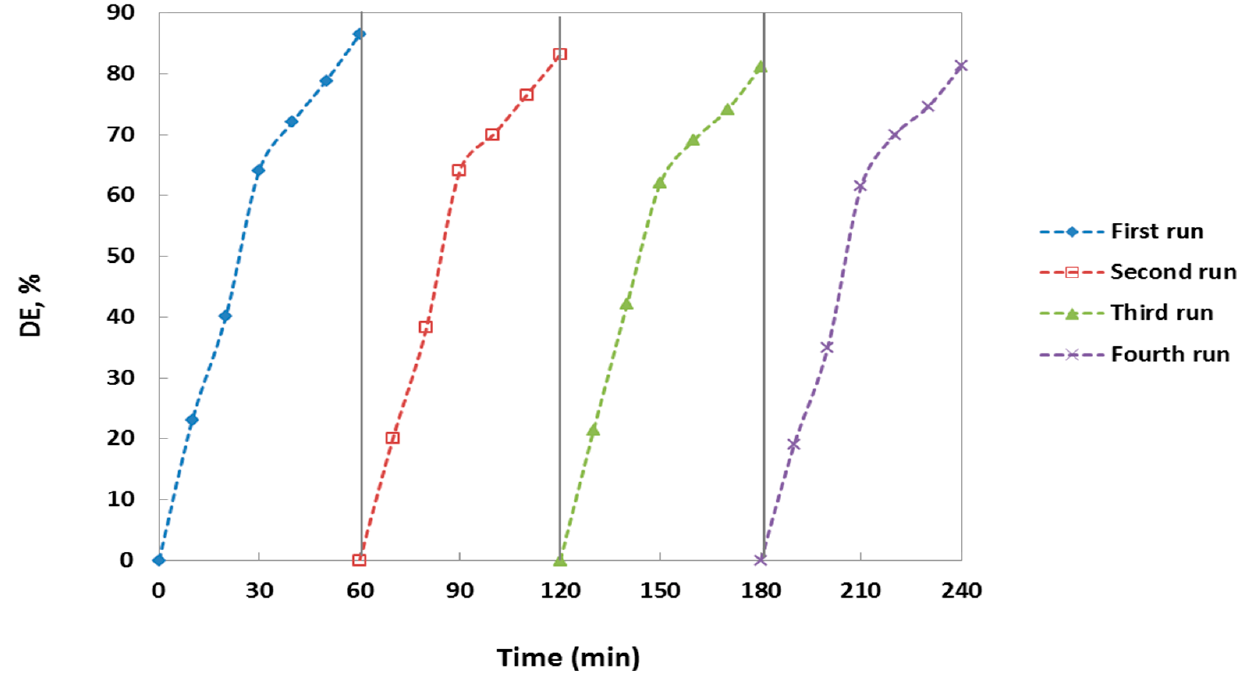
Figure 12. Reusability of Tb-doped CdSe within four consecutive runs.